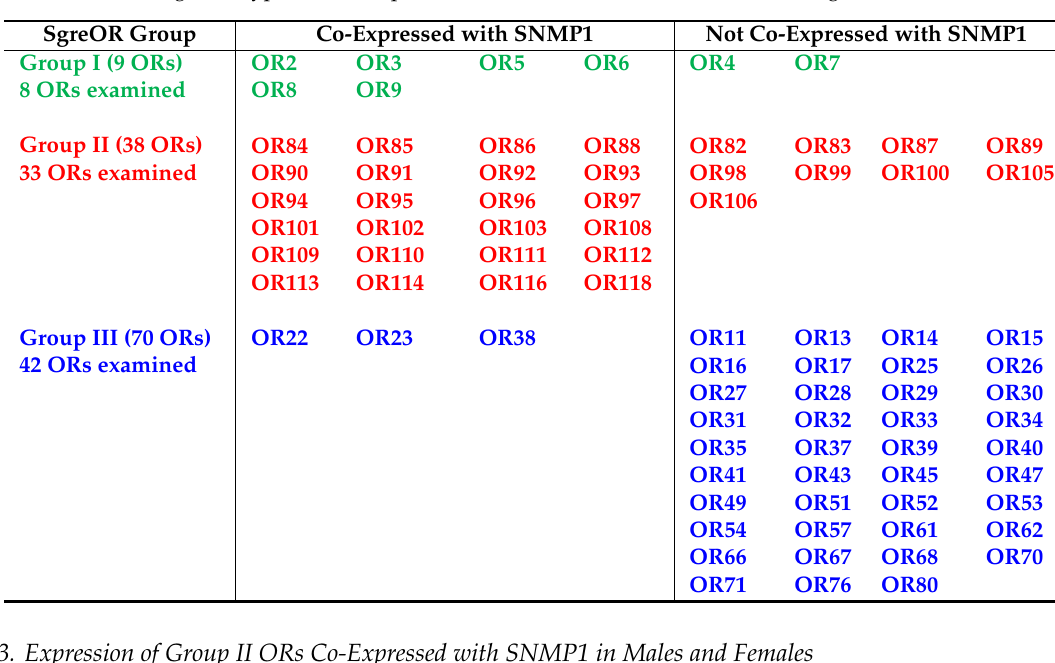
Table 1. Summary of SgreORs from group I-III that are co-expressed with SNMP1. The SgreORs are categorized in the relevant groups and indicated by the color code given in the schematic image of the phylogenetic tree depicted in Figure 1. In total, based on the results of FISH experiments, 33 out of the examined 83 SgreOR types are co-expressed in OSNs with SNMP1, whereas 50 SgreORs are